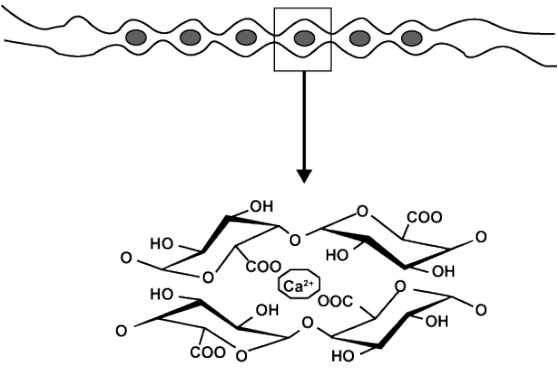
Figure 5. Gelation of LM pectins in the presence of Ca 2+